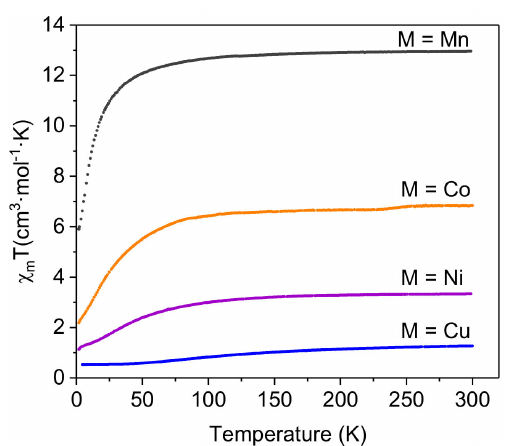
Figure 2. Magnetic susceptibility data for [M 3 ( µ -L) 6 (H 2 O) 6 ] − 6 complexes within 300–2 K